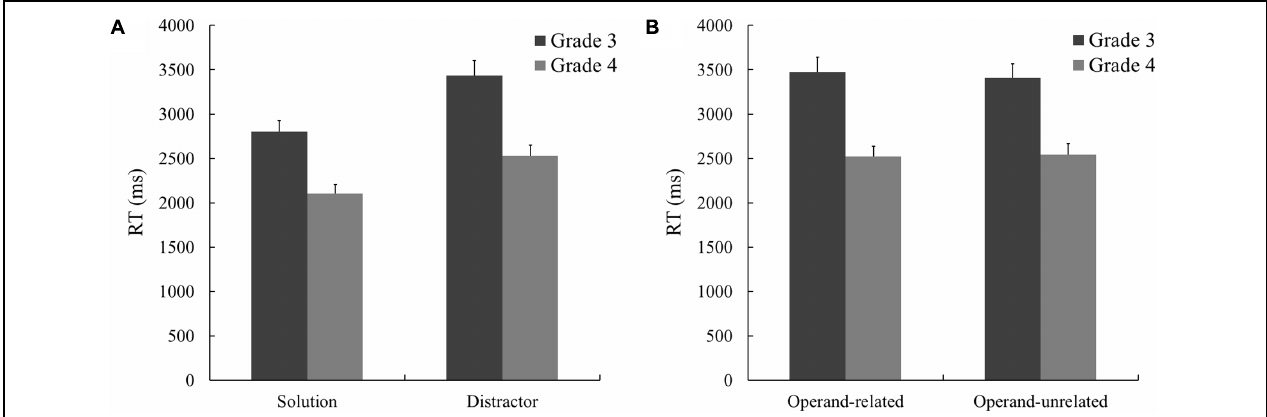
TABLE 2 | Mean response times (RTs) and error rates (and SDs) for multiplication trials.